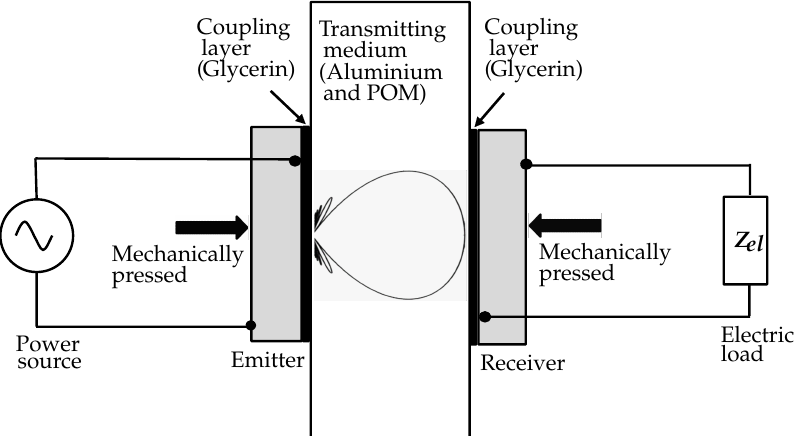
Figure 1. Simplified diagram of an acoustic power link, consisting of an emitting unit connected to a power source, a transmitting medium, and a receiving